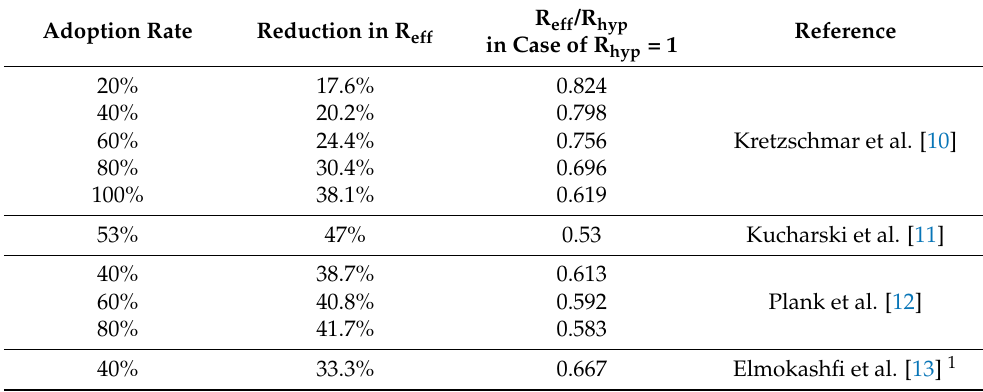
Table 1. Reduction in R-value as a function of the adoption rates of digital contact tracking apps.